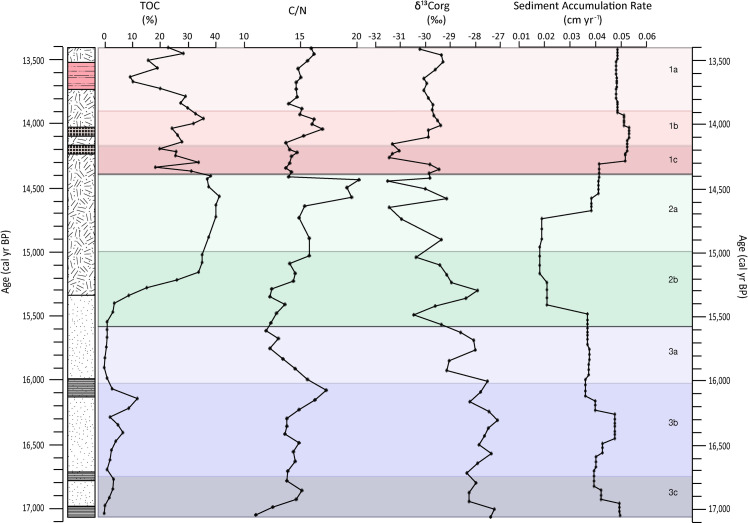
Profiles of TOC, C/N, δ13C and sediment accumulation rates by age.